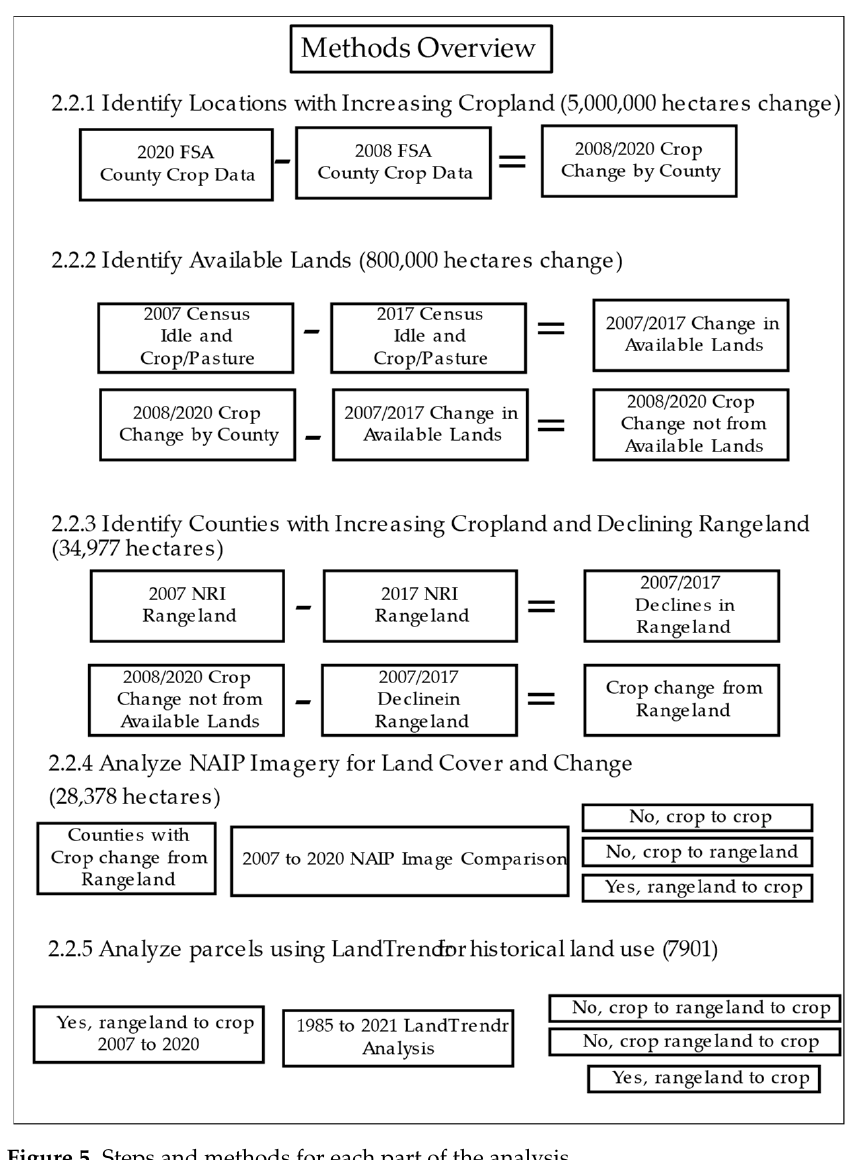
Figure 5. Steps and methods for each part of the analysis.